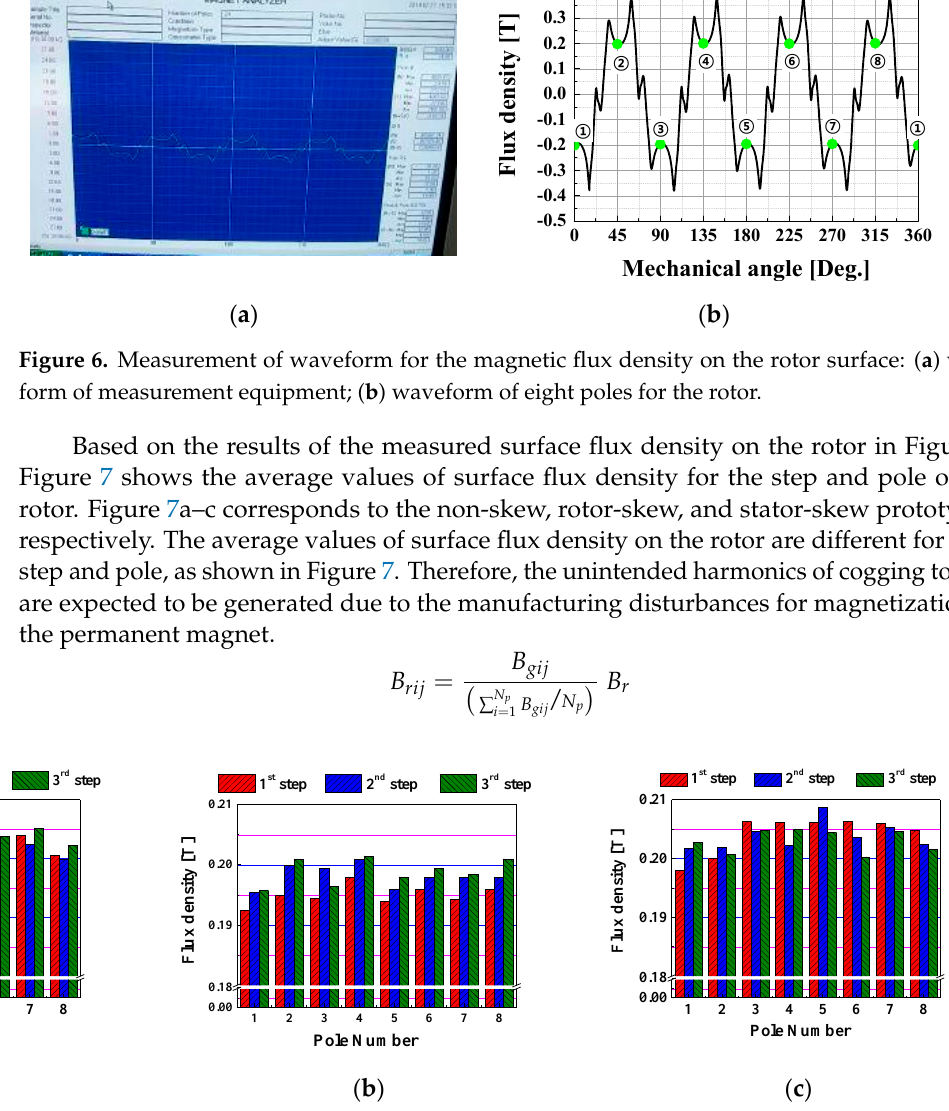
Figure 7. Flux density of each pole on the rotor surface of three prototypes: ( a ) non-skew; ( b ) rotor- skew; and ( c ) stator-skew.